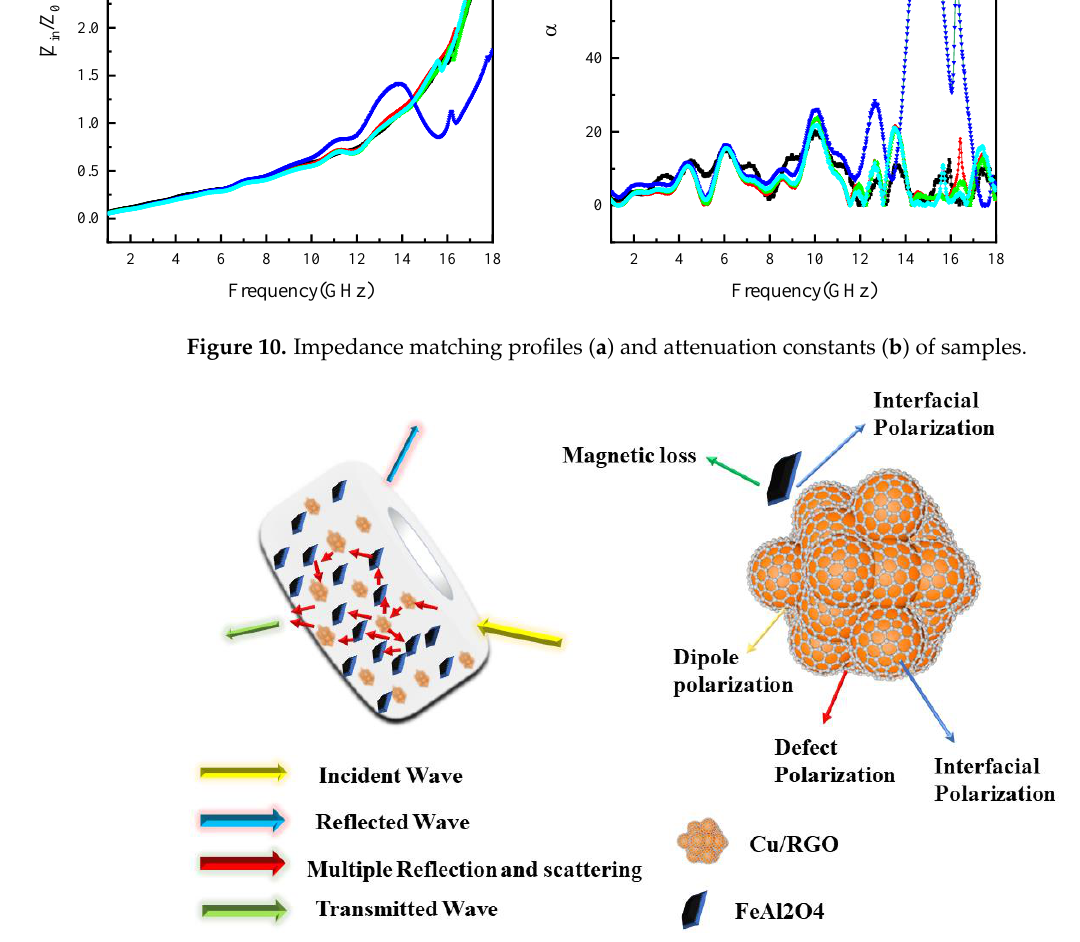
Figure 11. Schematic of microwave absorption mechanisms of the FeAl 2 O 4 /Cu/RGO.